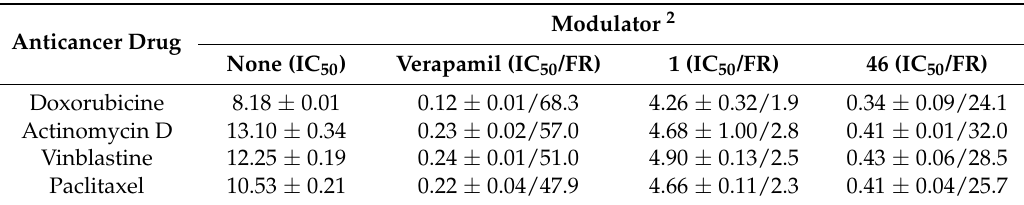
Table 6. Multi-drug resistance (MDR)-reversing activity of compound 46 compared to quercetin and verapamil 1